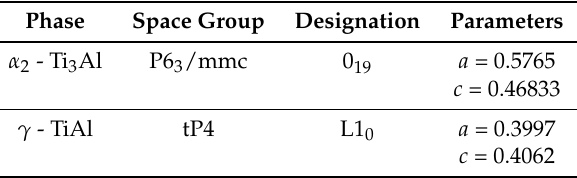
Table 1. Parameters of